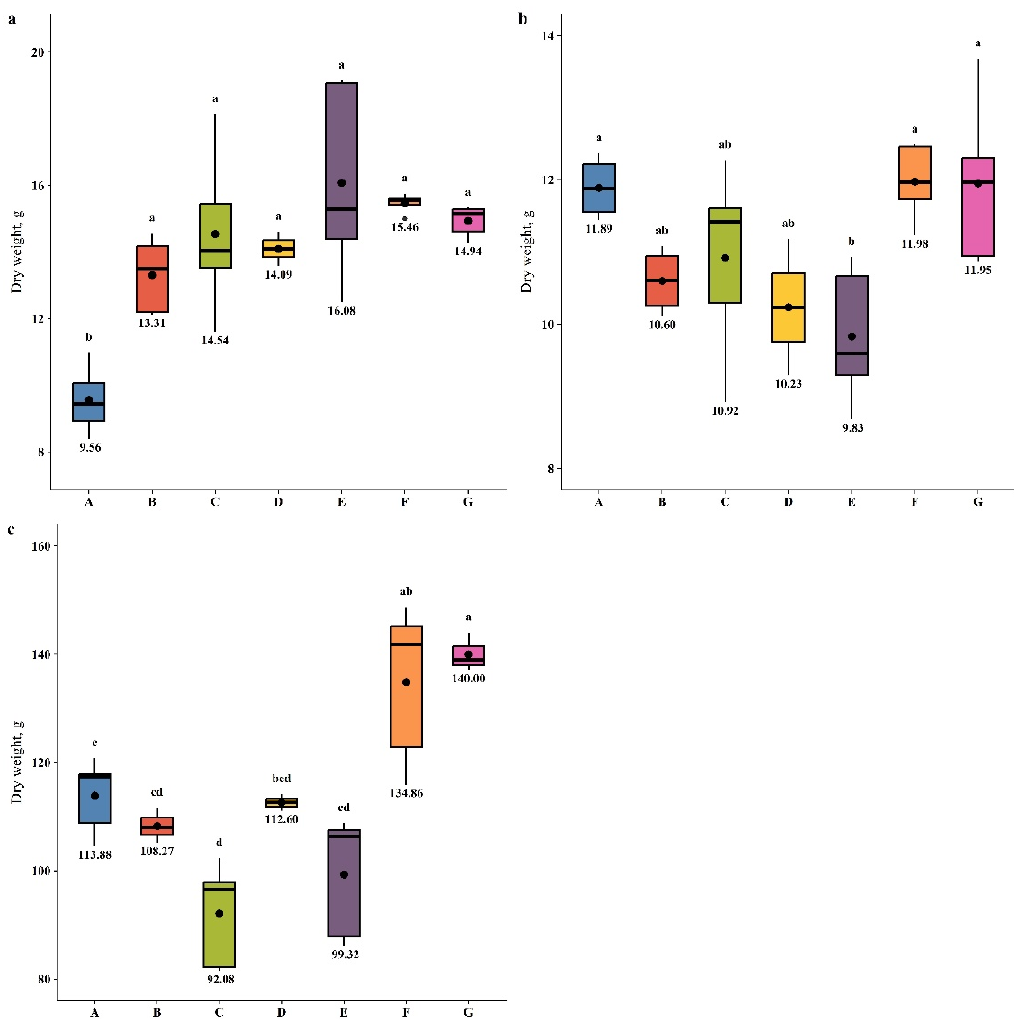
Figure 2. M. × giganteus biomass productivity (DW) in the TEs-contaminated soil in the presence of PGPB strains for: ( a ) leaves; ( b ) stems; ( c ) roots. Different letters within one plant part indicate a significant difference between treatments.